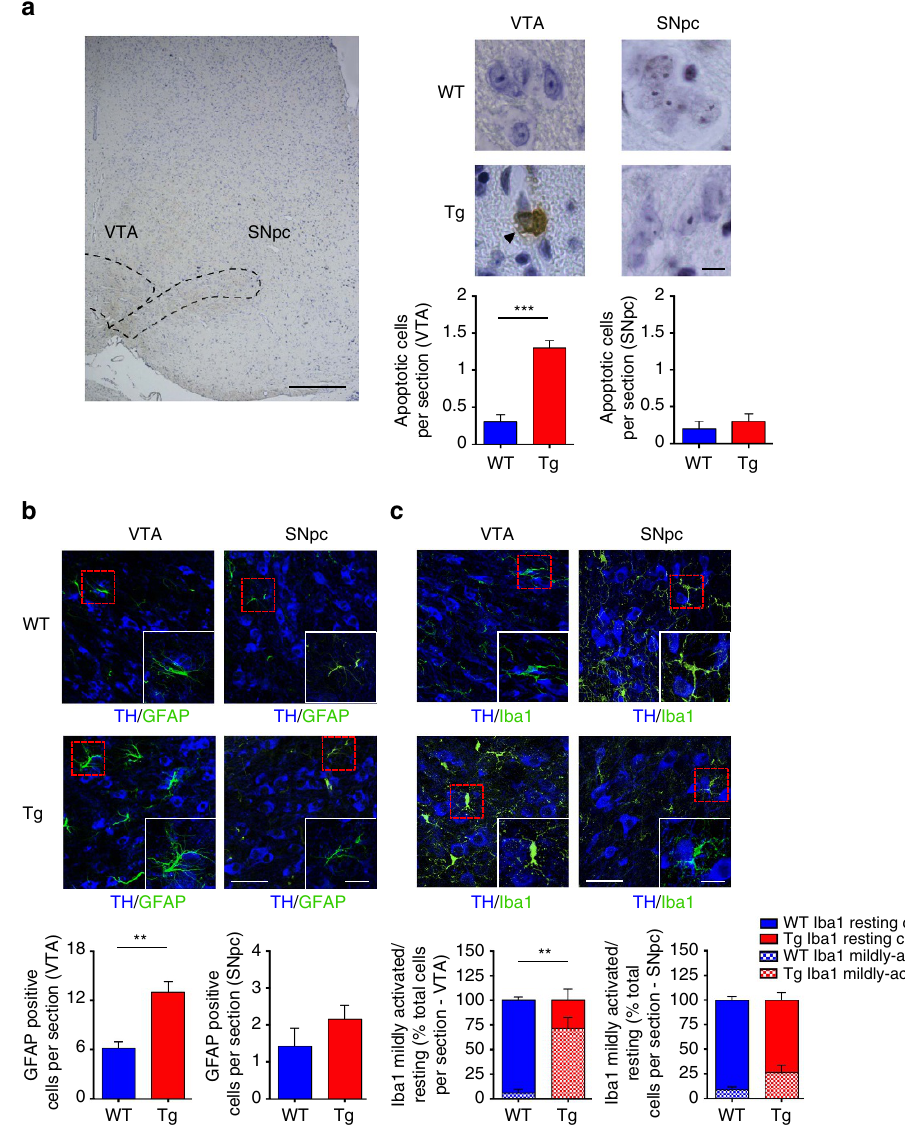
Figure 2 | VTA DAergic neuronal death in Tg2576 mice at pre-plaque stage is associated with apoptosis and glia inflammation. ( a ) Coronal brain hemi- section delineating VTA and SNpc areas (dashed lines; scale bar, 250 m m) and representative photomicrographs of TUNEL-positive neurons from 3-month- old WT and Tg2576 mice (scale bar, 10 m m). The intense dark-brown staining indicates apoptotic cells (arrowhead). Sections were Nissl-counterstained (light blue). The bar graphs represent the average number of TUNEL-positive apoptotic neurons per section in the analysed areas ( n ¼ 7 mice per genotype, 9 sections per animal; two-tailed unpaired t -test *** P o 1.00 (cid:3) 10 (cid:2) 4 ). ( b ) Analysis of confocal Z-stack double-labelling of TH- and GFAP- immunostaining in brain sections containing the VTA and SNpc from 3-month-old mice (scale bar, 50 m m). Insets show individual GFAP-positive cells at higher magnification (scale bar, 20 m m). The bar plots represent the mean number of GFAP-positive cells per section in the indicated areas ( n ¼ 7 mice per genotype, 9 sections per animal; two-tailed unpaired t -test ** P ¼ 0.002). ( c ) Double-labelling for TH and Iba1 in brain sections containing the VTA and SNpc from 3-month-old mice (scale bar, 50 m m). The insets show examples of resting microglia in WTmice and in the SNpc of Tg2576 mice, characterized by round cell bodies and long processes, and a mildly activated cell in the VTA of Tg2576 mice with more intense fluorescence, enlarged cell body and retracted processes (scale bar, 20 m m). Note also the increased proliferation of Iba1-positive cells in the Tg2576 VTA. The bar plots represent the mean number of Iba1-positive resting and mildly activated cells shown as percentage of the total number of Iba1-positive cells per section ( n ¼ 4 mice per genotype, 9 sections per animal; for the ratio of resting/mildly activated cells: two-tailed unpaired t -test ** P ¼ 0.003). Data are mean ±